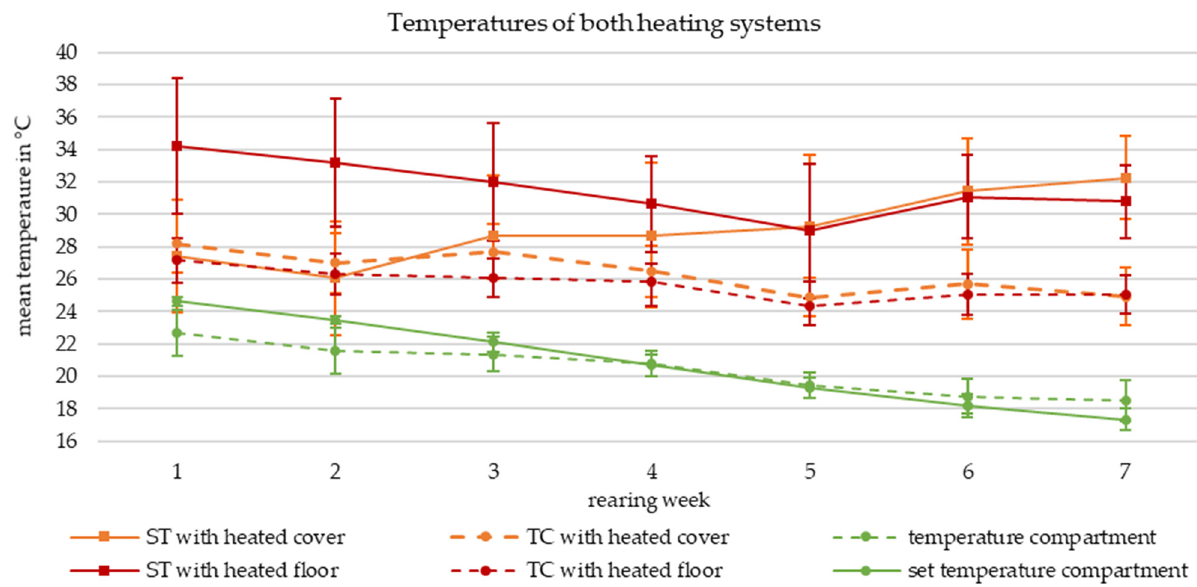
Figure 3. An average profile of all surface temperatures (ST) of the lying areas (12 sensors) and the air temperatures under the covers (TC) (eight sensors) and in the compartments (four sensors), in addition to the set air temperature in the compartments over all three heating periods. The mean temperatures for each rearing week, which were formed from the records taken every minute over the three rearing periods, are shown. The bars drawn at each data point indicate the standard deviation.